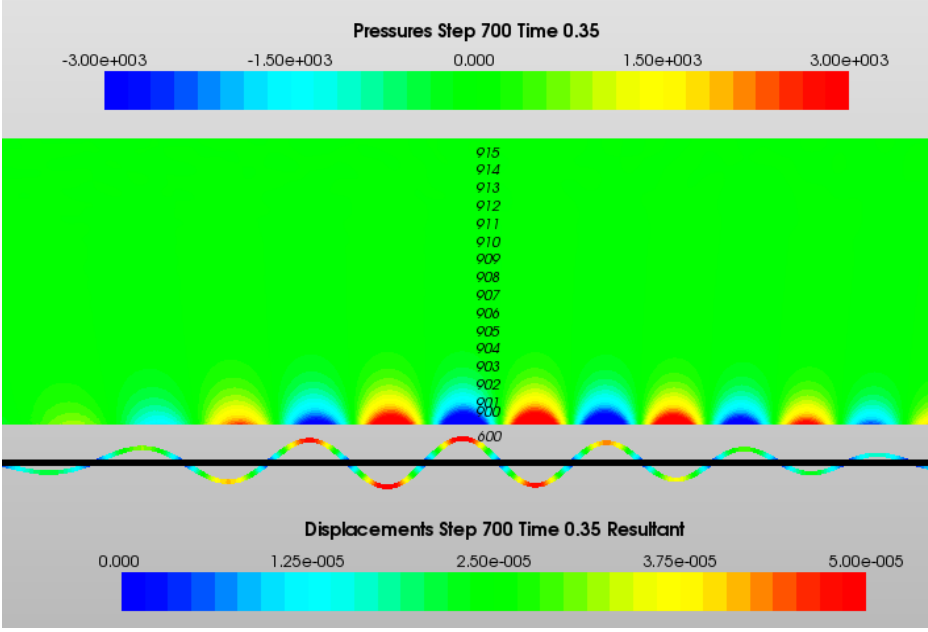
Figure 6. A snapshot view of the flexural wave as an exaggerated displacement of the baseplate. This is shown as a horizontal black line between its exaggerated displacements, in colour, peaking at 50 µ m. The water finite element edges are not shown here, but a set of monitor nodes are numbered in the water column up to the water surface (16 m deep). The oscillating pressures covered a range ±3 kPa.